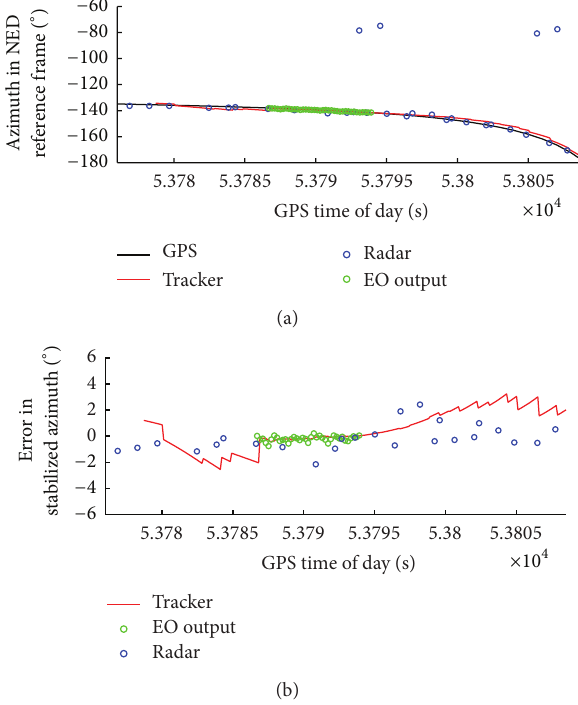
Figure 9: Intruder azimuth in NED (GPS, tracker, radar, and EO output) and relative estimation errors (tracker, radar, and EO output with respect to GPS) as a function of GPS time in the considered scenario.